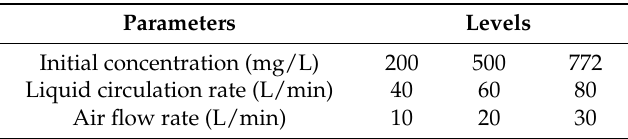
Table 1. Parameters and their